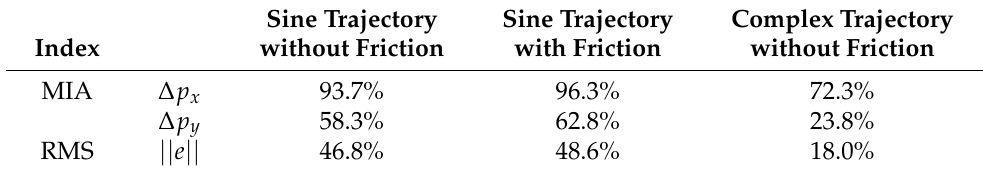
Table 5. Percentage increase in IQV tracking performance over